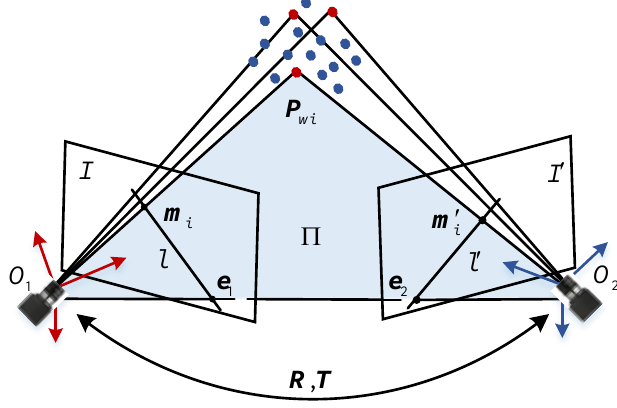
Figure 1. Epipolar geometry in binocular vision.